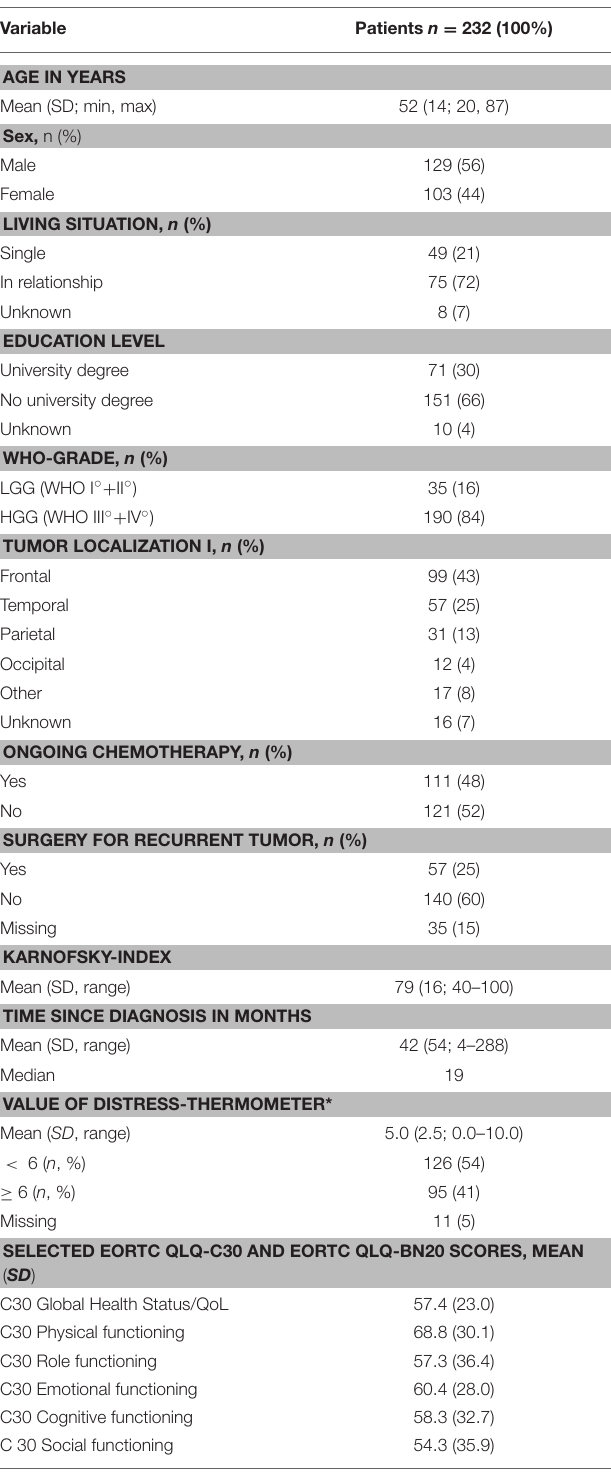
TABLE 1 | Clinical and demographic data of the patient sample and results of the psychosocial assessment using the Distress Thermometer (DT; score ≥ 6 indicated significant burden in brain tumor patients), the European Organization for Research and Treatment of Cancer Quality of Life Questionnaire (EORTC QLQ)-C30 + BN20, and the Patients’ Perspective Questionnaire